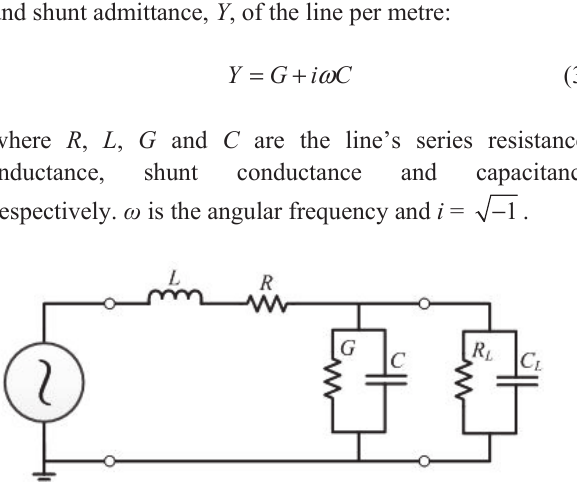
Fig. 4: The equivalent circuit for the impedance of the leads. R L and C L represent the load impedance, Z L